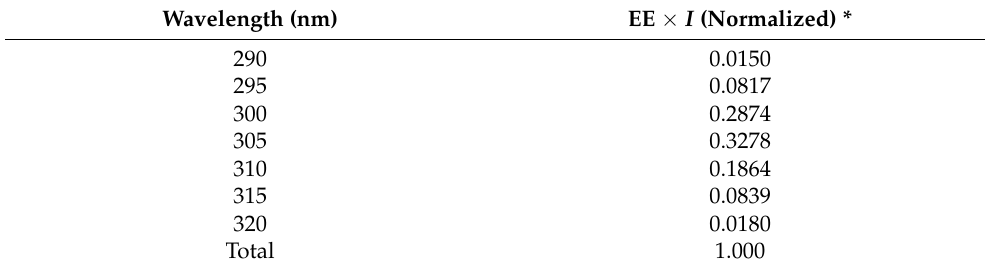
Table 1. The normalized product function used in the calculation of Sun Protection Factor (SPF)